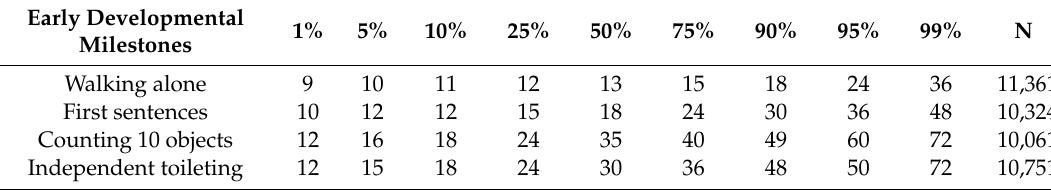
Table A3. Distribution of the Starting Age of Achieving Early Developmental Milestones (in months). Early